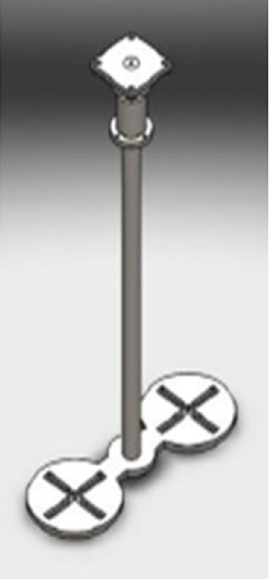
Fig. 8. The previous 2-positions mass handler.